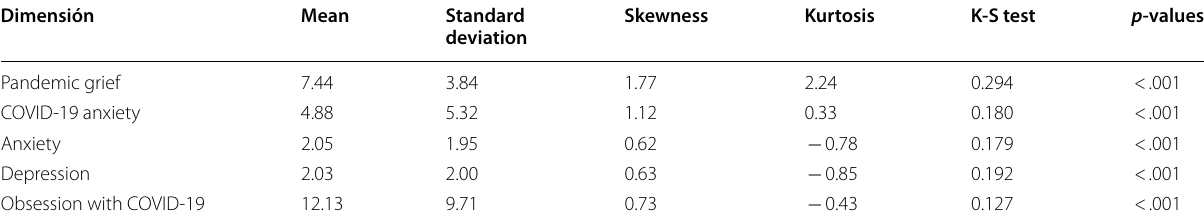
Skewness Kurtosis deviation